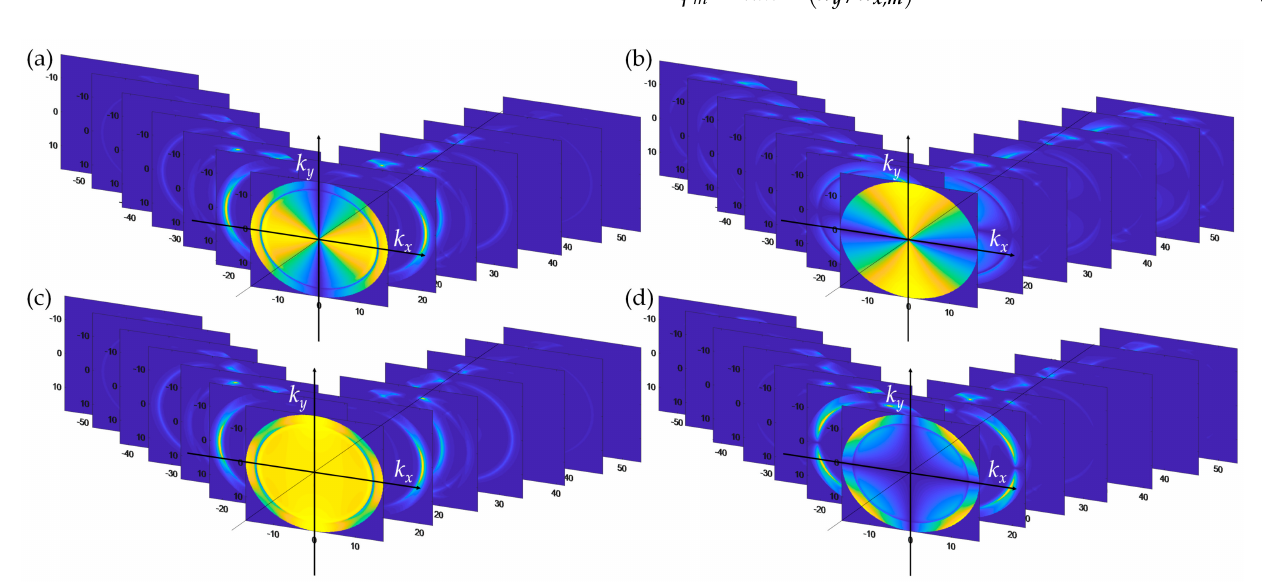
(cid:0) (cid:1) k x , m , k y , ( b ) E TE , m